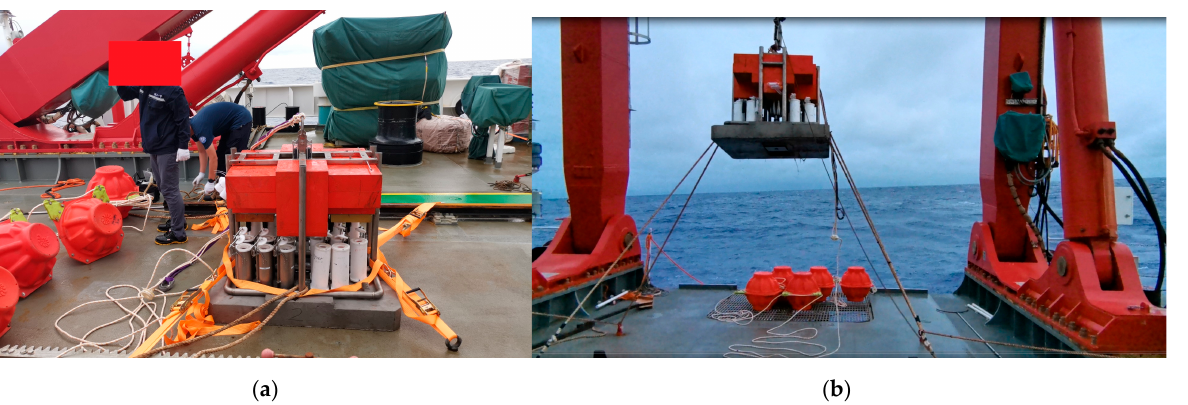
Figure 9. ( a ) The lander on the deck; ( b ) the lander to be released. Table 6. The depth information comes from acoustic release.